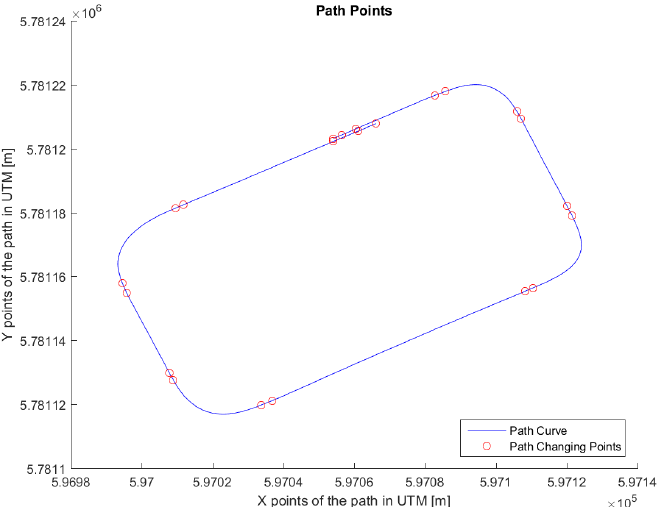
Figure 7. Trajectory for the test